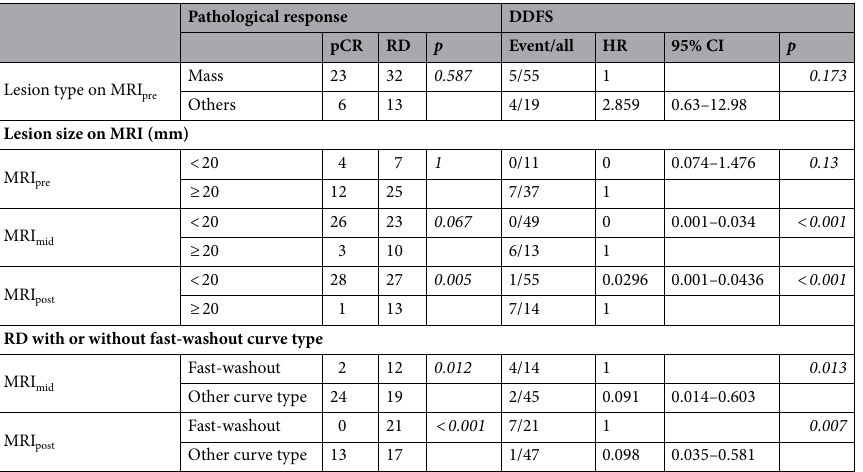
Table 3. Comparison of pathological response and distant disease-free survival (DDFS) by DCE-MRI findings. Others: non-mass enhancement (NME) and mixture of mass and NME, DCE-MRI: dynamic contrast-enhanced magnetic resonance imaging, RD: residual disease, HR: hazard ratio, p : two-sided p